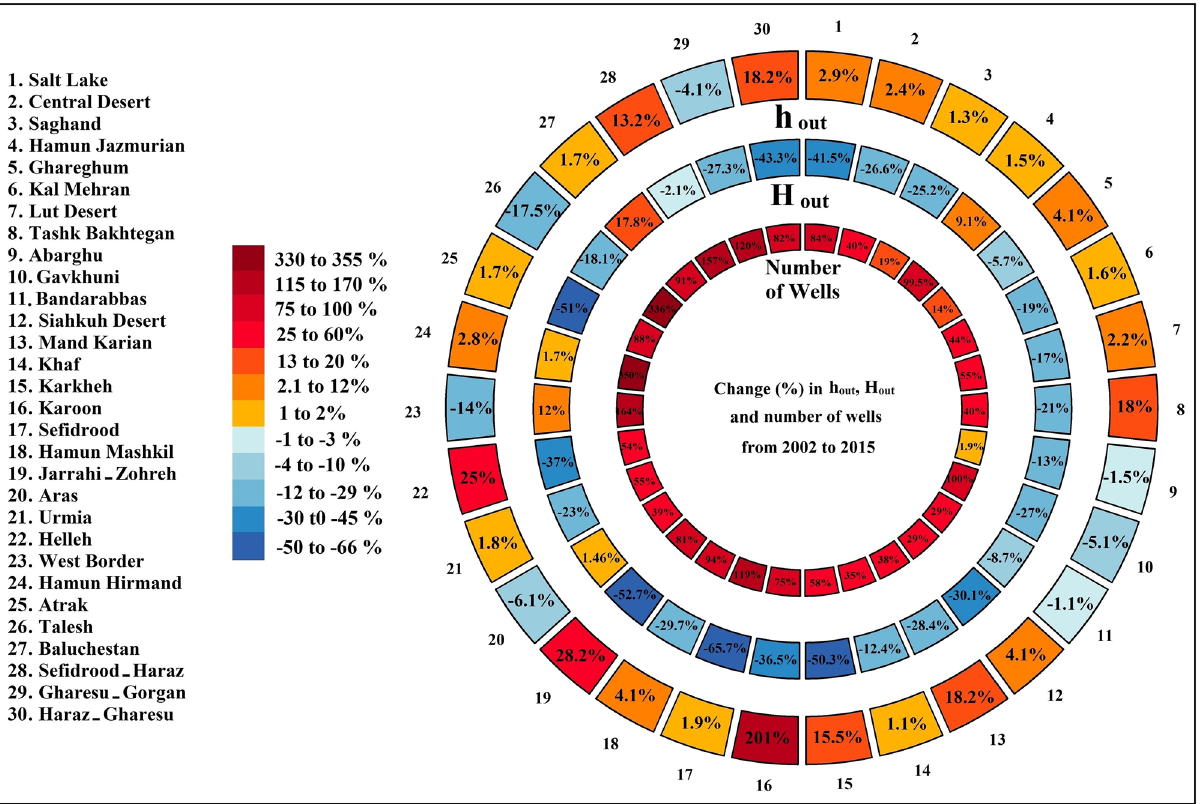
Figure 4. Relative changes in normalized human annual outflow ( h out ), along with relative changes in total human outflow ( H out ) and the number of wells from 2002 to 2015 across major Iranian basins, arranged in outer circle, middle circle and the inner circle, respectively. Basins are sorted with the same order configured in Fig. 1 (This figure is created using R).